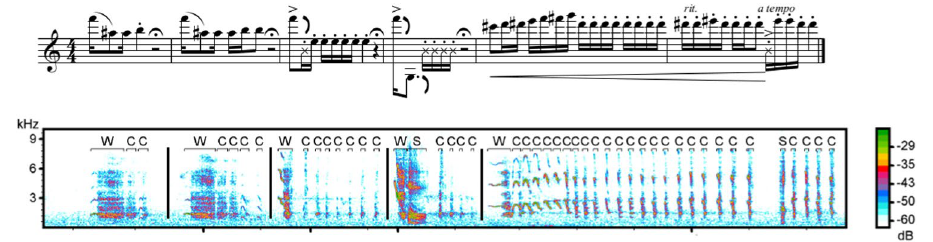
Figure 1. ( a ) Proposed musical notation of male song corresponding to the parts represented in the spectrogram. ( b ) Sample spectrogram of male rock hyrax song. Different vocal elements are marked and coded as W -Wail, C -Chuck and S -Snort. The representation order of singing bouts corresponds to natural temporal progression of a typical male hyrax song (beginning – low complexity, middle – low/intermediate complexity. end – high complexity). Vertical lines mark bout